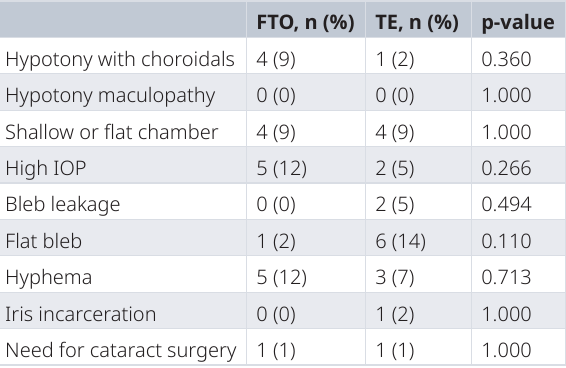
Table 2. Postoperative complications and